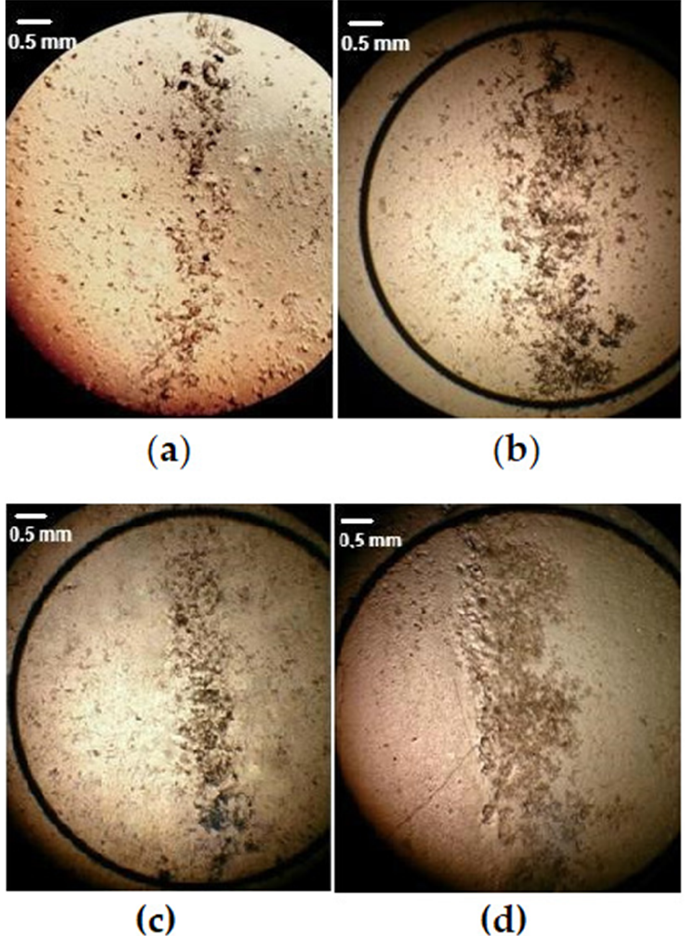
Figure 4. Focusing of EcN bacteria in a gradient MF above the contact surface of the two permanent magnets shown in Figure 3: ( a ) bacterial cells cultivated on standard medium (control); ( b ) bacterial cells cultivated on standard medium with the addition of chelates; ( c ) bacterial cells cultivated on standard medium under the influence of external MF with magnetic field flux density 1500 Oe (0.15 T); ( d ) bacterial cells cultivated on a standard medium with the addition of chelates under the influence of external MF with magnetic field flux density 1500 Oe (0.15 T).